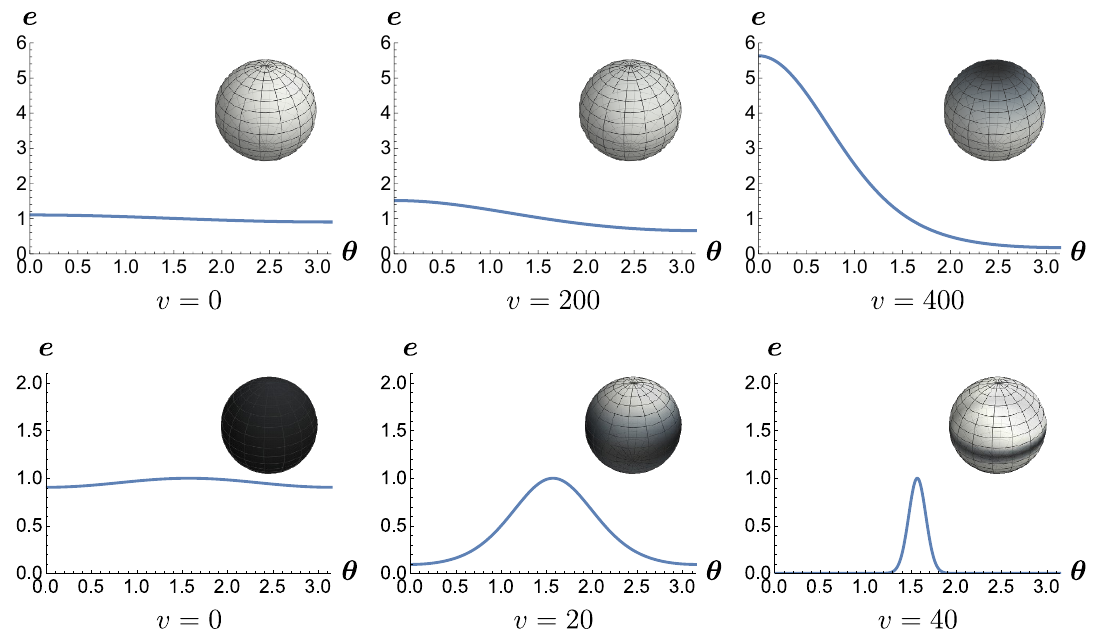
Figure 5 . Snap shots of solutions (3.11) at di(cid:11)erent times. The almost uniform black holes evolve into the non-uniform black holes, but there is no end-point. We display the density plot on the sphere in insets. First row : We used the ‘ = 1 term with a 1+ > 0 (all other a ‘ (cid:6) = 0), and set the radius r c = 0 : 7. Second row : we used the ‘ = 2 term with a 2+ < 0 (all other a ‘ (cid:6) = 0), and set the radius r c = 0 :